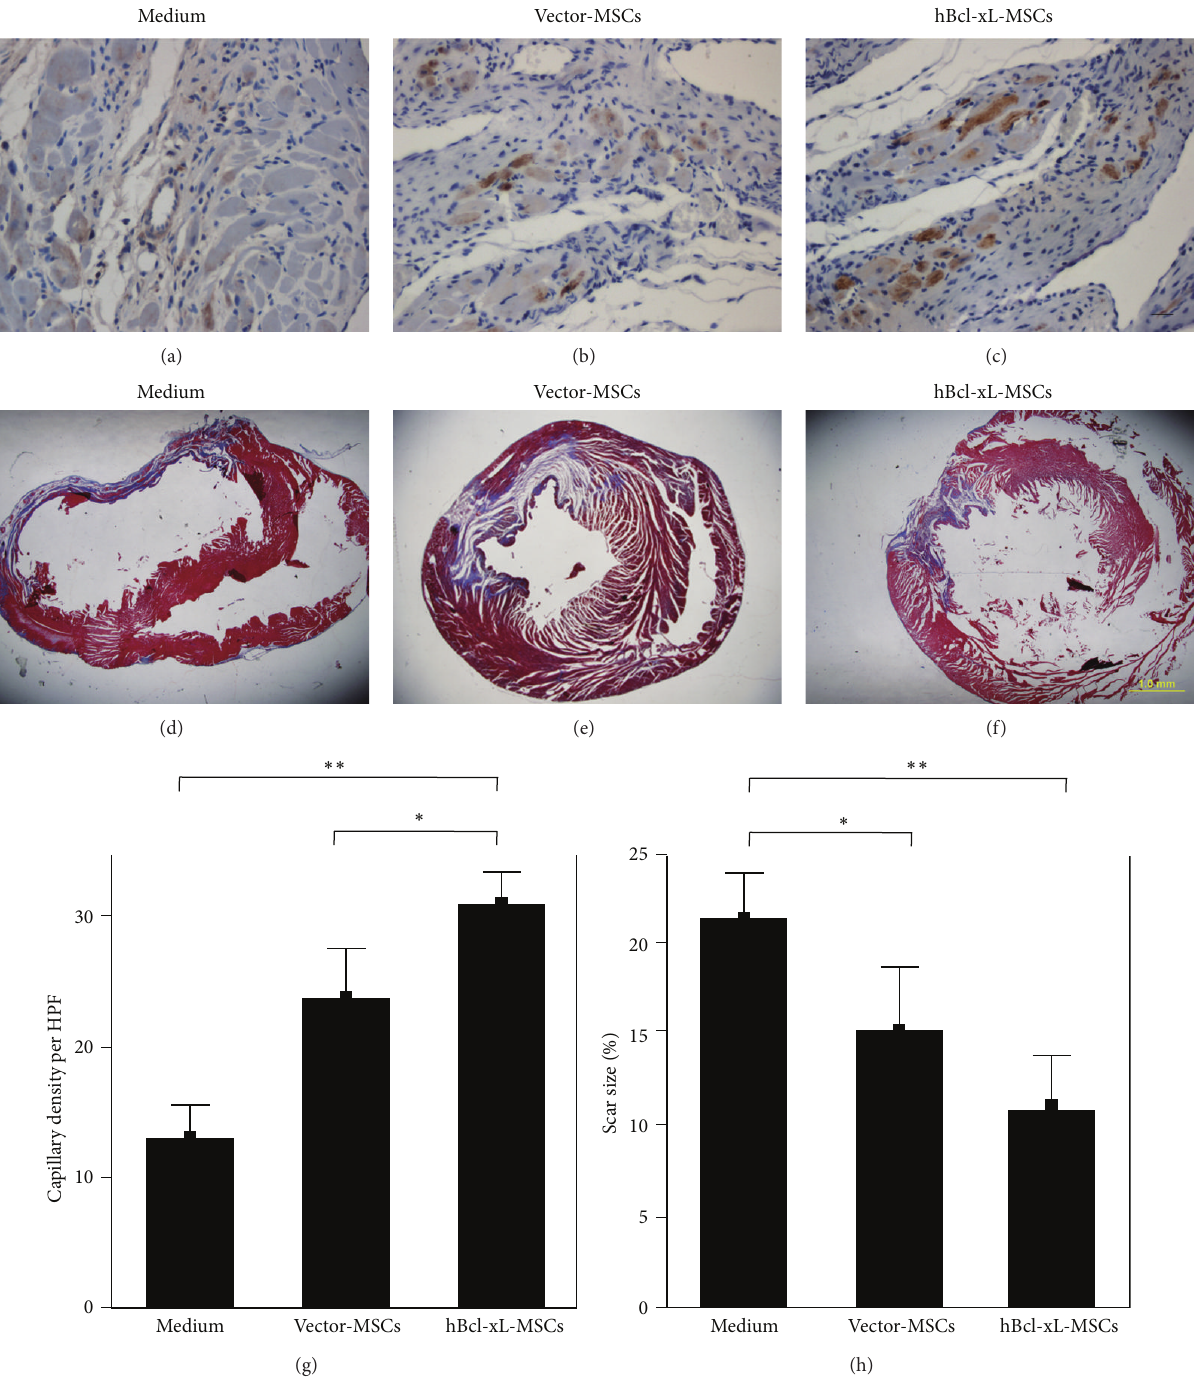
Figure 7: hBcl-xL-MSCs promoted angiogenesis and prevented scar formation in infarcted heart. ((a)–(c)) Evaluation of capillary density by von Willebrand factor staining at 4 weeks after transplantation of medium (a), vector-MSCs (b), or hBcl-xL-MSCs (c). ((d)–(f)) Assessment of scar formation by Trichrome-Masson staining at 4 weeks after medium (d), vector-MSCs (e), or hBcl-xL-MSCs (f) transplantation. (g) Capillary density was presented as the number of vessels per high-power field. (h) Scar size was presented as the percentage of the collagen deposition area to the whole section area of the left ventricle. Values are mean ± SD ( 𝑛 = 6 , ∗ 𝑃 < 0.01 , ∗∗ 𝑃 < 0.001 ). Scale bar represents 50 𝜇 m (c) and 1mm (f),